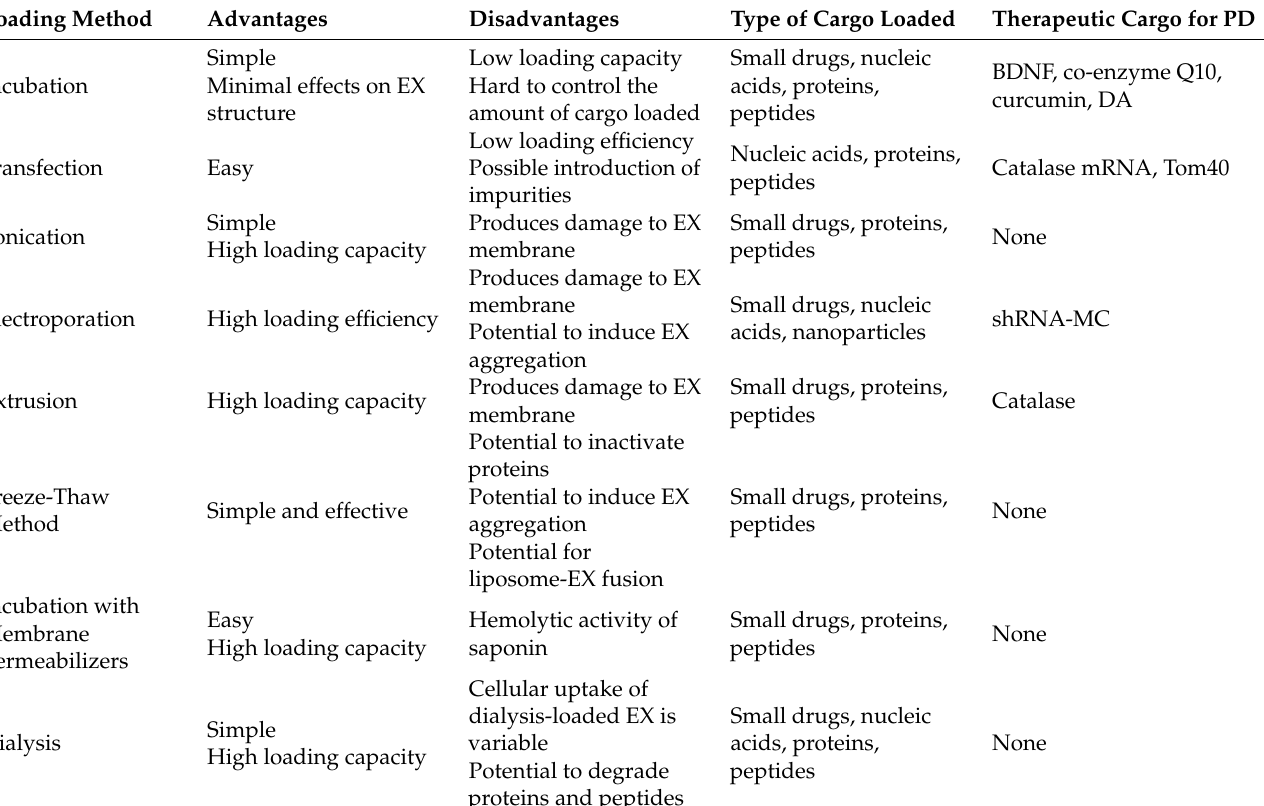
Table 1. Advantages and disadvantages, type of cargo that can be loaded, and whether a therapeutic cargo has been used to treat PD for each loading